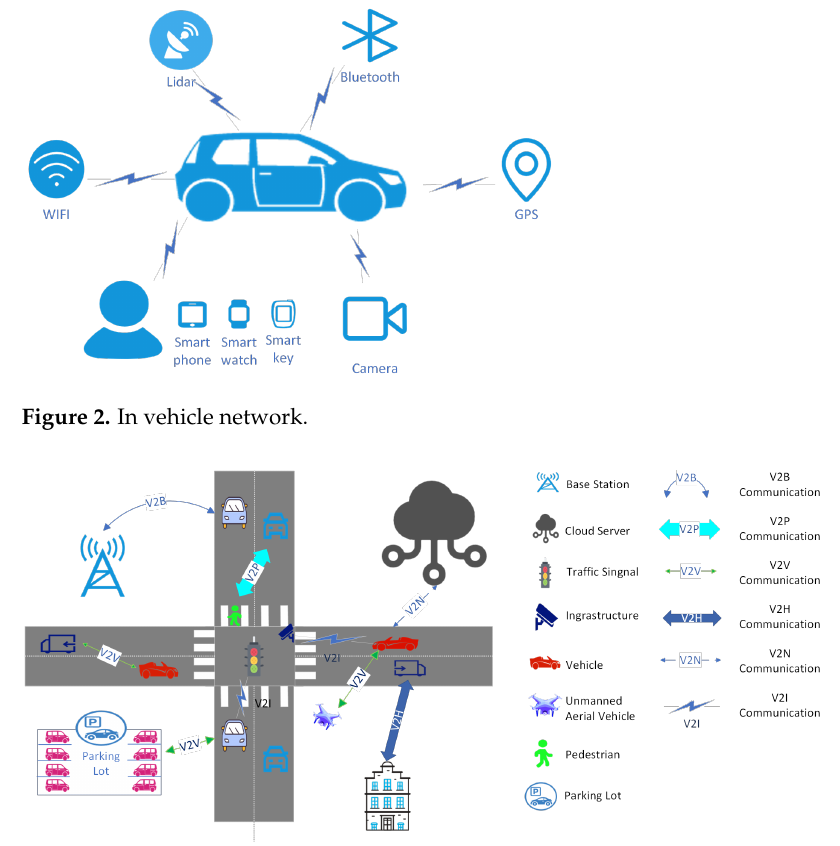
Figure 3. Inter vehicle